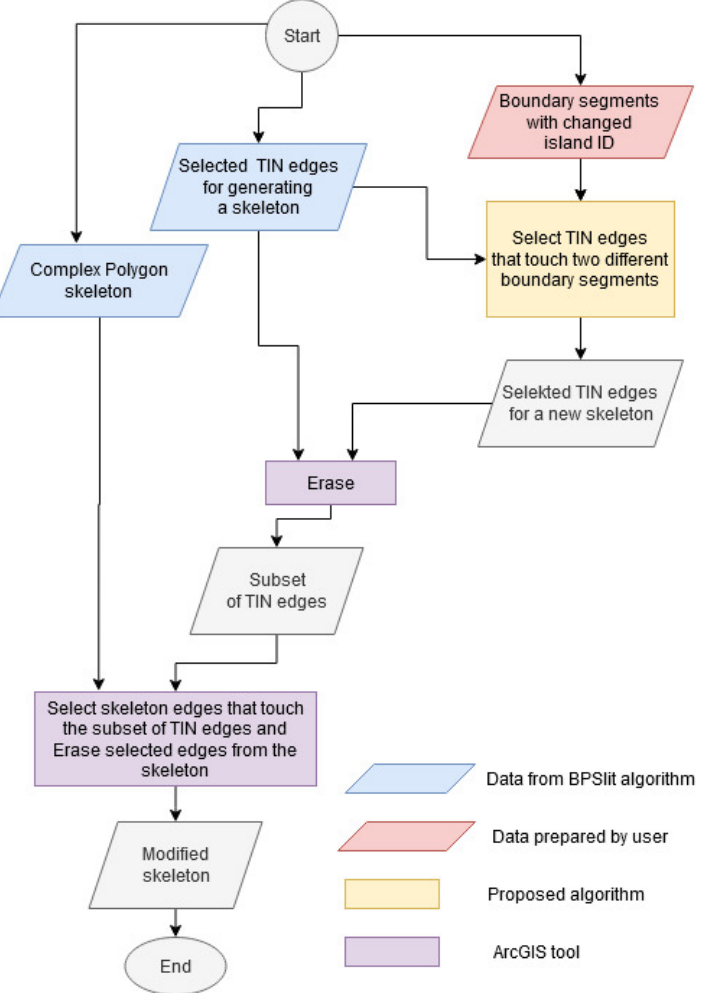
Figure 11. Flowchart of the algorithm which modifies a polygon skeleton by changing island identifiers.